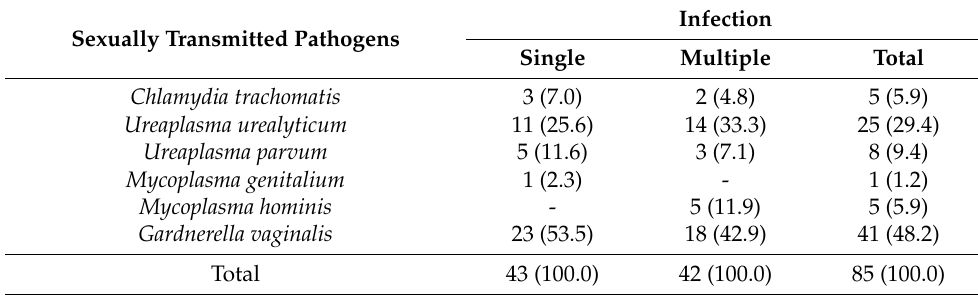
Table 1. PANA RealTyper™ STD-positive results in random urine samples of men. Sexually Transmitted Pathogens